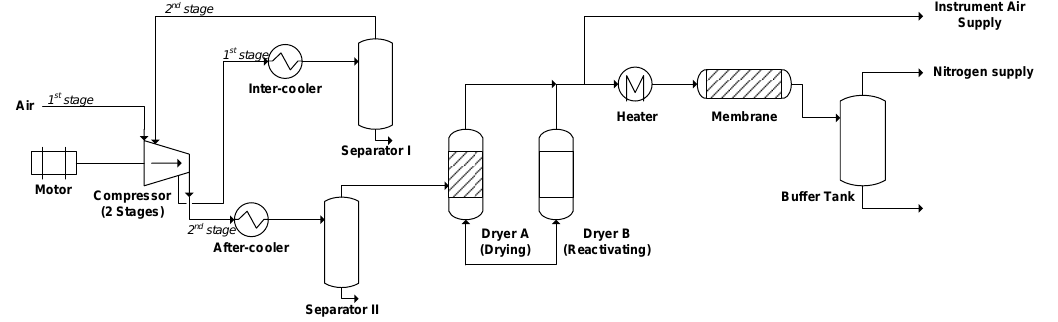
Figure 3. Process flow diagram (PFD) of air and nitrogen system.